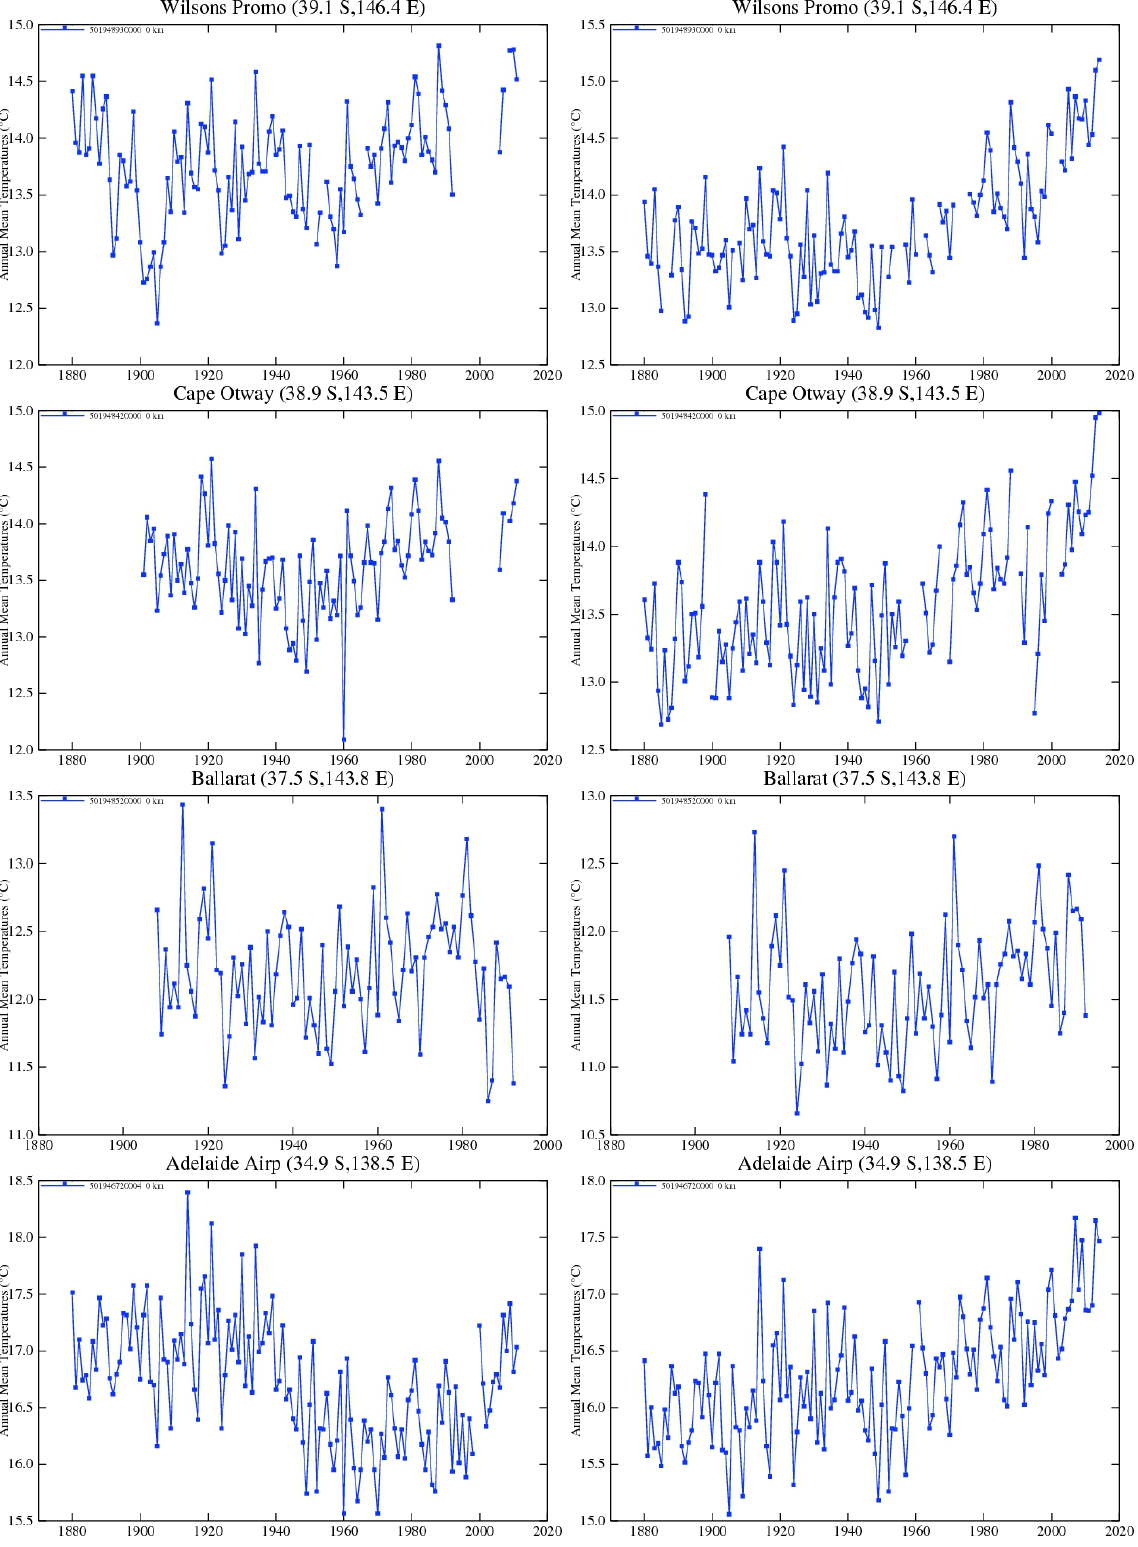
Fig. A.2: (Continued) GISS v2 vs. v3 temperature records for Darwin and Alice Springs, Northern Territory, Wilson Promontory, Cape Otway and Ballarat, Victoria, Adelaide Airport, South Australia, Eucla, Western Australia, Yamba, New South Wales, Brisbane/Eagle Farm, Queens- land, Carnarvon, Western Australia, Port Headland, Western Australia and Willis Island, an external territory of Australia. GISS v2 data on the left, GISS v3 data on the